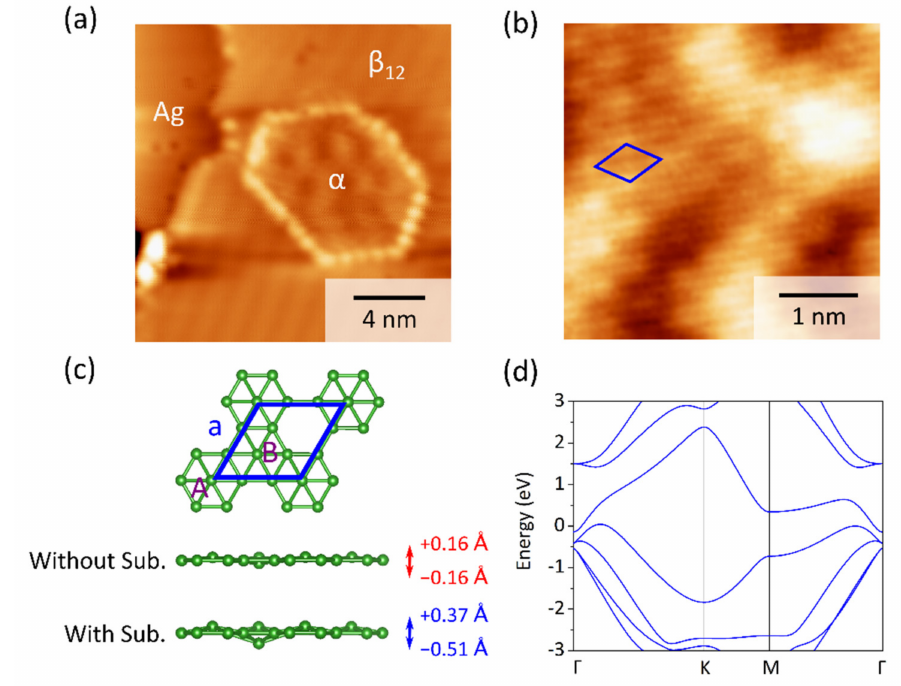
Figure 1. ( a ) STM image (1.3 V, 190 pA) of monolayer borophene sheet grown on Ag(111), showing an α domain between β 12 islands. ( b ) High-resolution STM image ( − 0.8 V, 190 pA) of the surface of α borophene; the unit cell is marked by a blue rhombus. ( c ) The model of planar α phase, shown together with the symmetric buckled α phase (relaxed without Ag(111) substrate) and asymmetric buckled α phase (relaxed on Ag(111) substrate). ( d ) The simulated electronic band structure of asymmetric buckled α